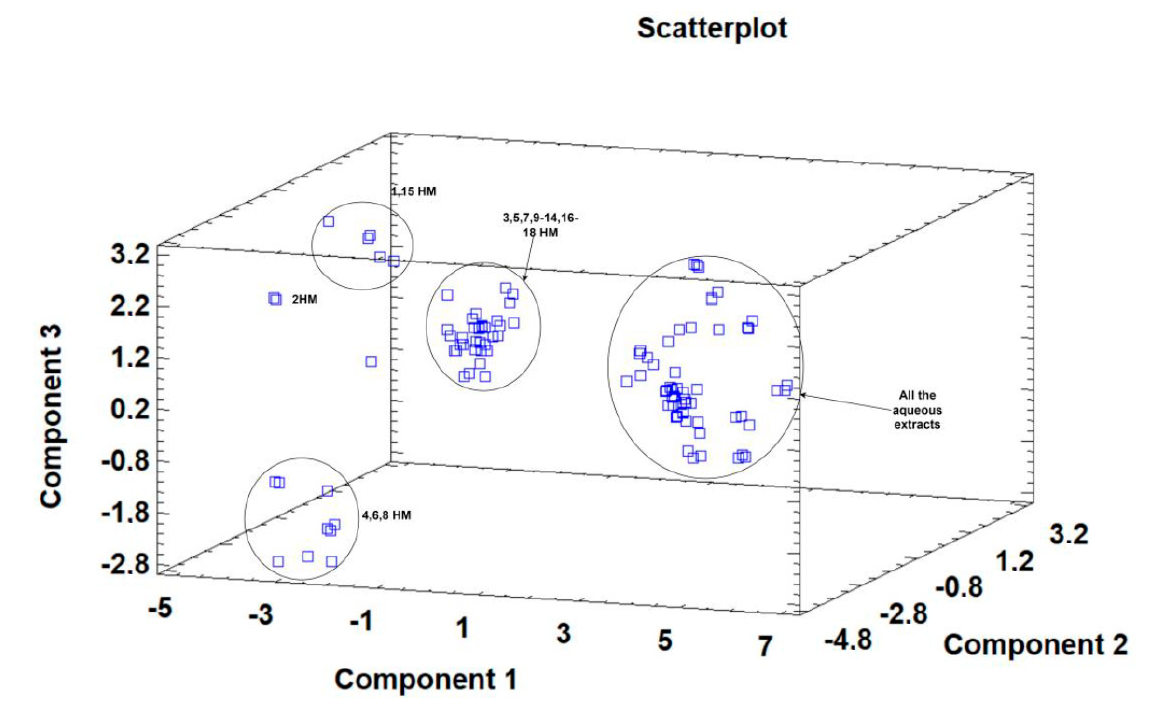
Figure 1. Three-dimensional scatterplot of principal components 1, 2, and 3 for the tested Withania somnifera samples extracted with two different protocols (hydromethanolic and aqueous extracts).